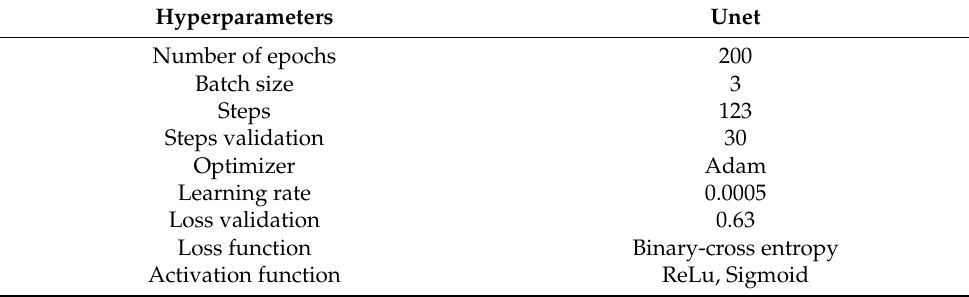
Table 2. The U-net training hyperparameter details.